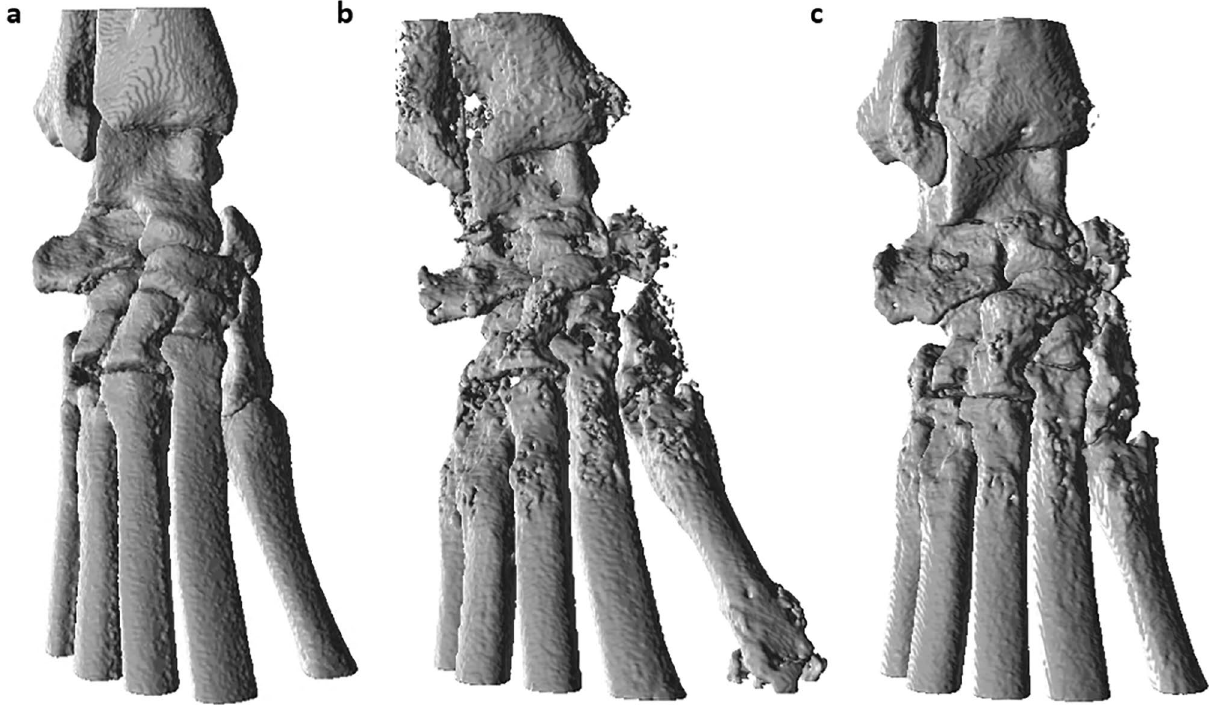
Figure 5. Representative in vivo µCT images from each group have been reconstructed in 3-D here, where ( a ) shows a naïve paw, ( b ) shows an untreated paw, and ( c ) shows a treated paw. A threshold of 3500 AU was used to generate these images in Pmod software (https:// www. pmod. com/, Version